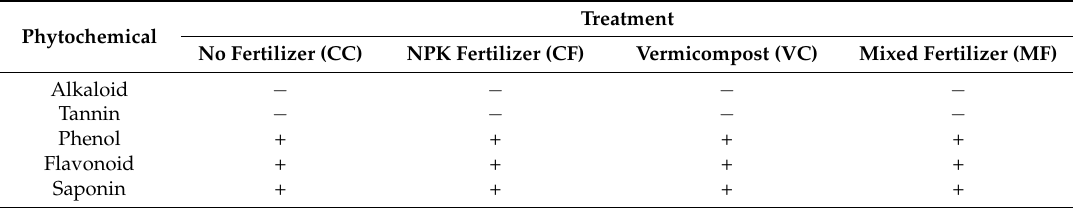
Table 1. Effect of plant growth supplements on availability of phytoconstituents in methanolic extracts of Clinacanthus nutans leaves.